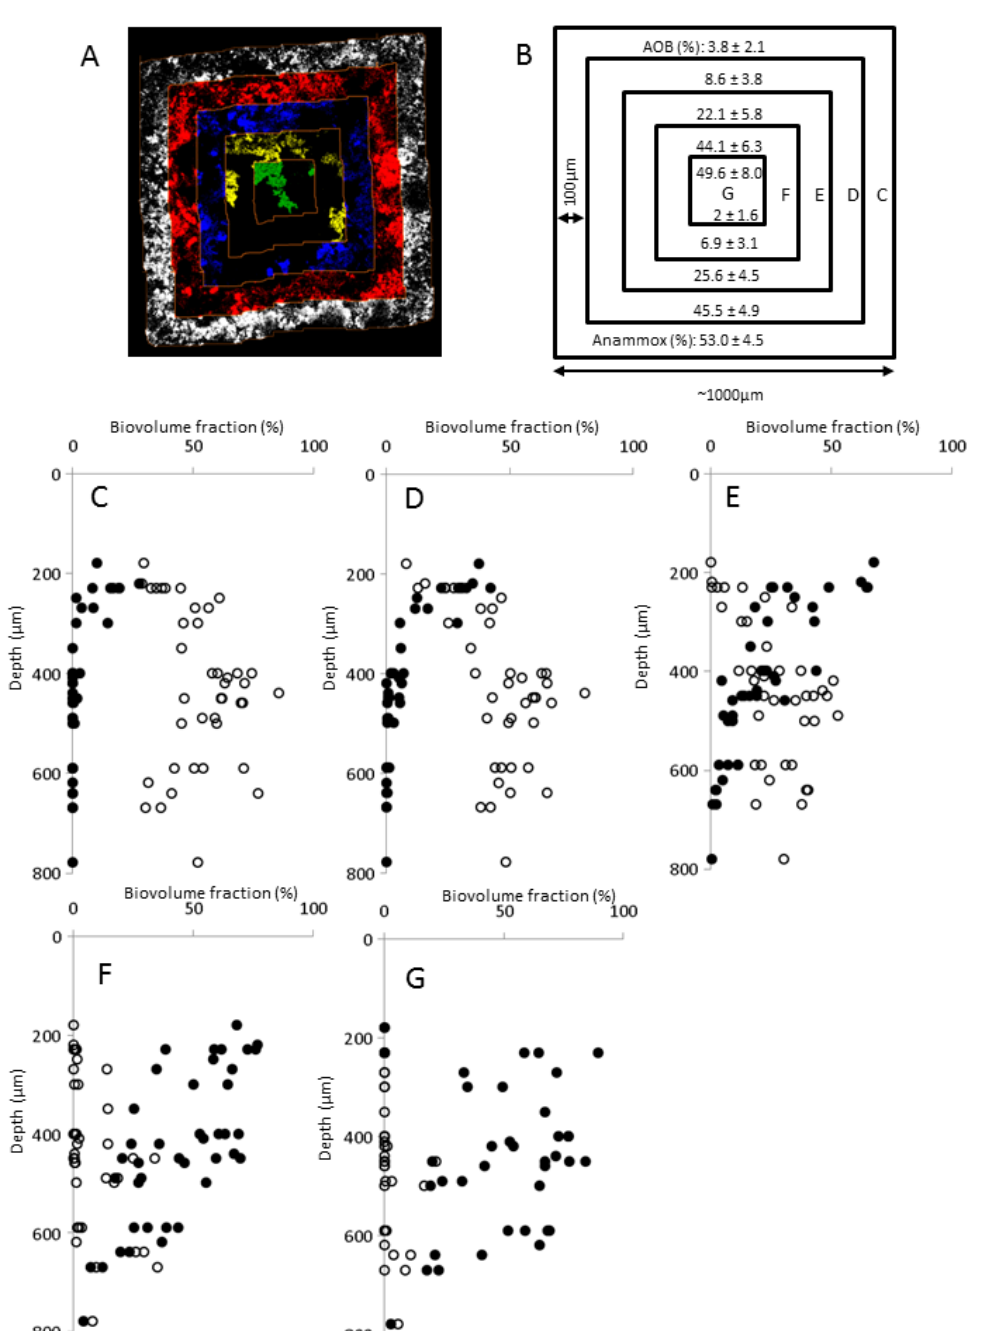
Figure 3. Assembled FISH “wall-to-wall” micrographs of biofilm from the biofilm carrier compartments in the x , y dimension. ( A ) Example of the multidirectional slicing procedure, where each colored area represents a 100 μ m thick region of the biofilm from a particular distance from the compartment wall; ( B ) Schematic representation of the 100 μ m thick slices, showing average biovolume fractions throughout all depths ( z ) of AOB and anammox bacteria in the carrier compartments. Average ± 95% confidence intervals, n = 41 ( n = 37 for slice 400–500 μ m); and ( C – G ) Biovolume fractions of anammox bacteria (open circles) and AOB (solid circles) in the concentric areas (colored “slices”) at different depths ( z ) in the carrier compartments. The designations ( C – G ) refer to the concentric areas at different distance from the compartment wall, as depicted in ( B